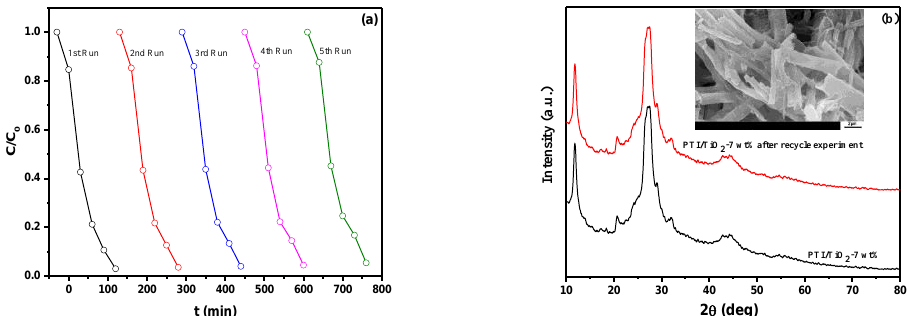
Figure 7. ( a ) Recycle experiments of PTI/TiO 2 -7wt% for reduction of Cr(VI), ( b ) XRD pattern before and after the recycle experiment.